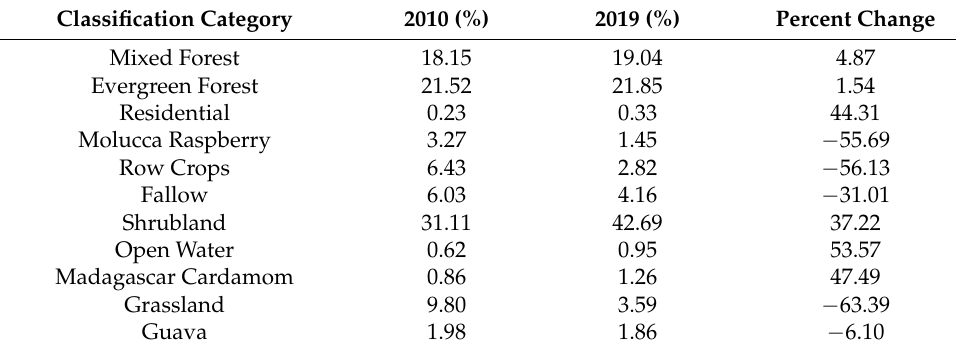
( a ) ( b ) Figure 10. Residential areas in 2019 (red boundary polygon) in the study area (extent shown in inset map) overlain over the 2010 classification map showing the increase in residential area extent and the emergence of new hamlets in 2019 for ( a ) a location east of the BNR and ( b ) northwest of the BNR.